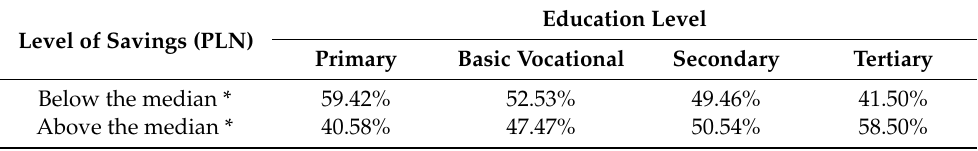
Table 3. Level of education of the farmer and the level of savings generated by small farms in Poland. Education Level Level of Savings (PLN) Primary Basic Vocational Secondary Tertiary Below the median * 59.42% 52.53% 49.46% 41.50% Above the median * 40.58% 47.47% 50.54%